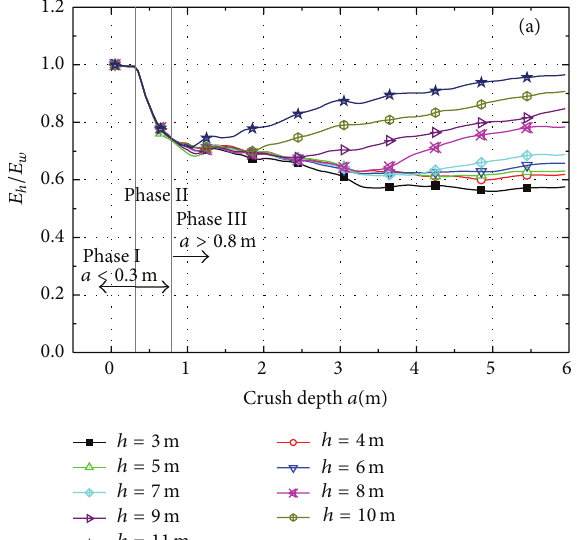
Figure 16: 𝐸 ℎ /𝐸 𝑤 for different pile-cap depths (10,000 DWT).